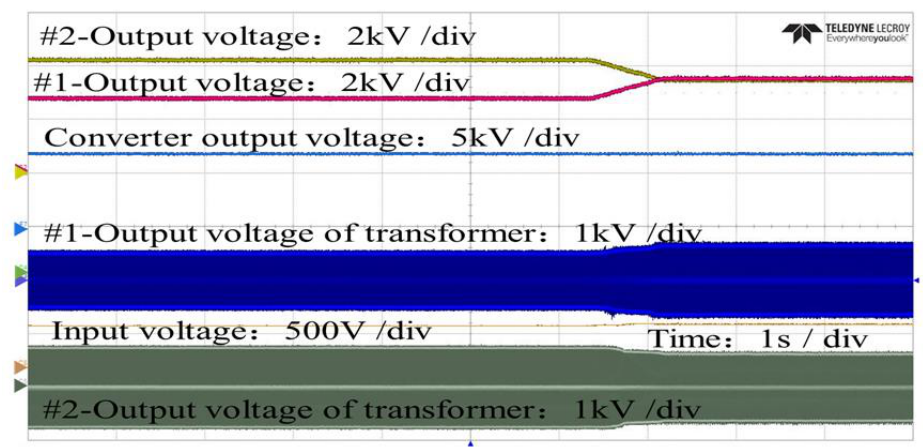
Figure 20. Output voltage around current sharing control.